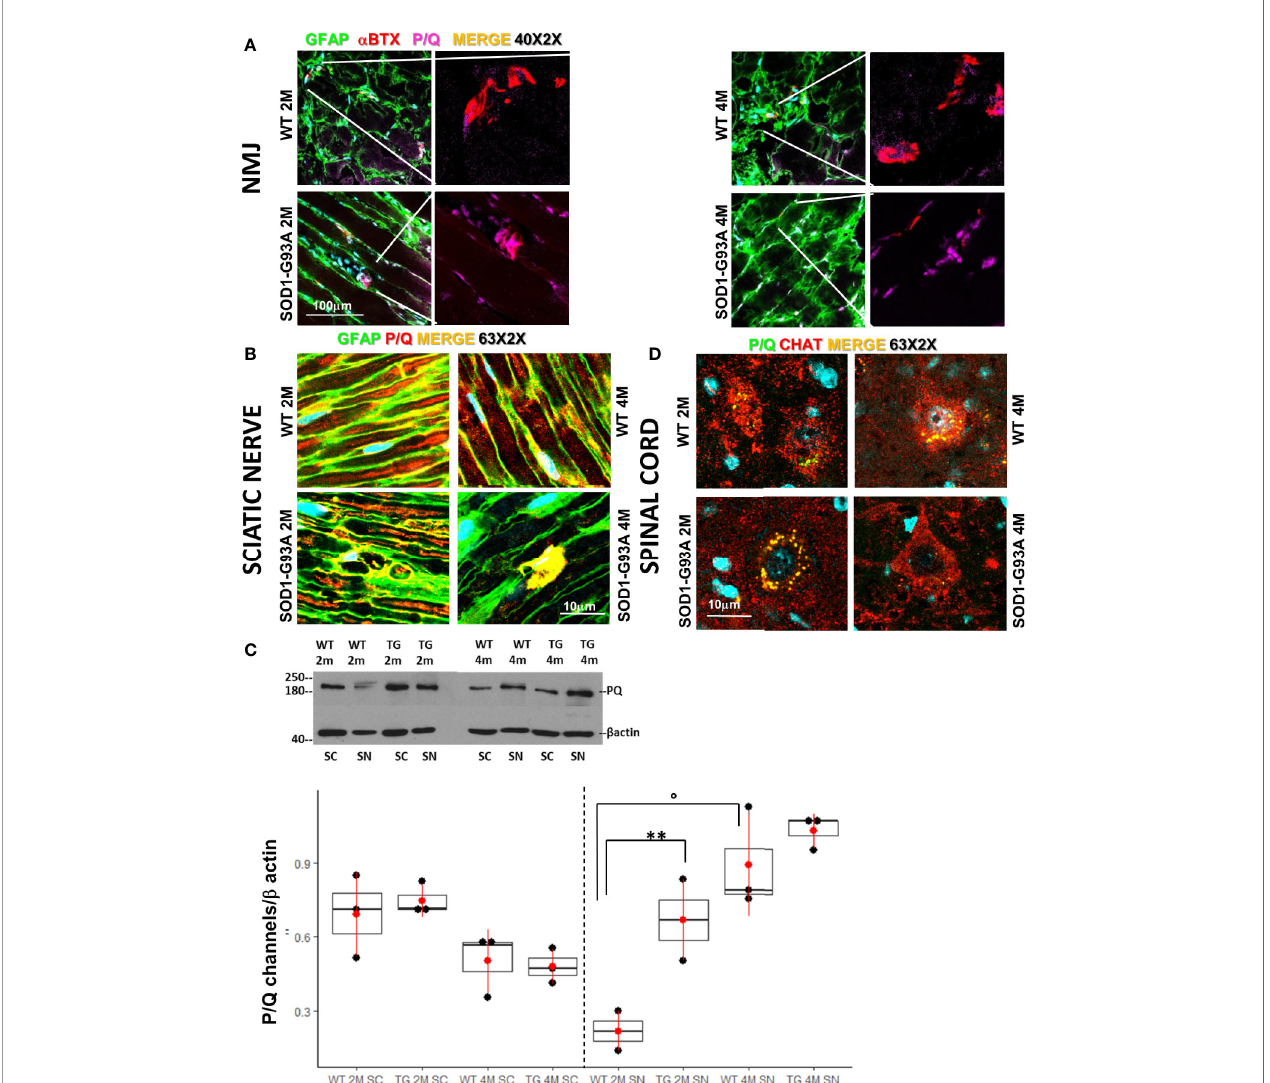
FIGURE 1 | Early degeneration of peripheral P/Q calcium channels in SOD1-G93A mice and effects on spinal neurons. (A) Representative examples of confocal images (magni fi cation 40X) of P/Q channels (violet) expression in NMJ (BTX – red) and nerve fi bers (GFAP – green) in 2 (2M) and 4 months (4M) WT and SOD1- G93A old mice. (B) Sciatic nerves localization and distribution (magni fi cation 63X - zoom 2X) of P/Q calcium channel (red) co-stained with GFAP (green – SCs) in WT and SOD1-G93A mice at 2M and 4M. (C) Western Blot analysis of P/Q calcium channels in spinal cord (SC) and sciatic nerve (SN) in WT and SOD1-G93A (transgenic – TG) mice both at 2M and 4M. (**p <0,01 vs WT of the same age; °p <0,05 vs 2M TG ; WB for SN N = 4 each group; WB for SC N = 3 each group; 3 experiments/group). (D) Colocalization (magni fi cation 63X zoom 2X) of P/Q calcium channels (green) and CHAT (red) in spinal (L2-L5) motor neurons in WT and SOD1-G93A mice both at 2M and 4M asymptomatic period (2 months - 2M) but not in 4 months (4M) old transgenic mice (H 3 = 6.86 p = 0.0671; Dunn-Test post-hoc TG 2M vs WT 2M p = 0.0257). This biggest amount of cells is due to the enhancement of circulating MCs (H 3 = 9.286, p = 0.025; Dunn-Test